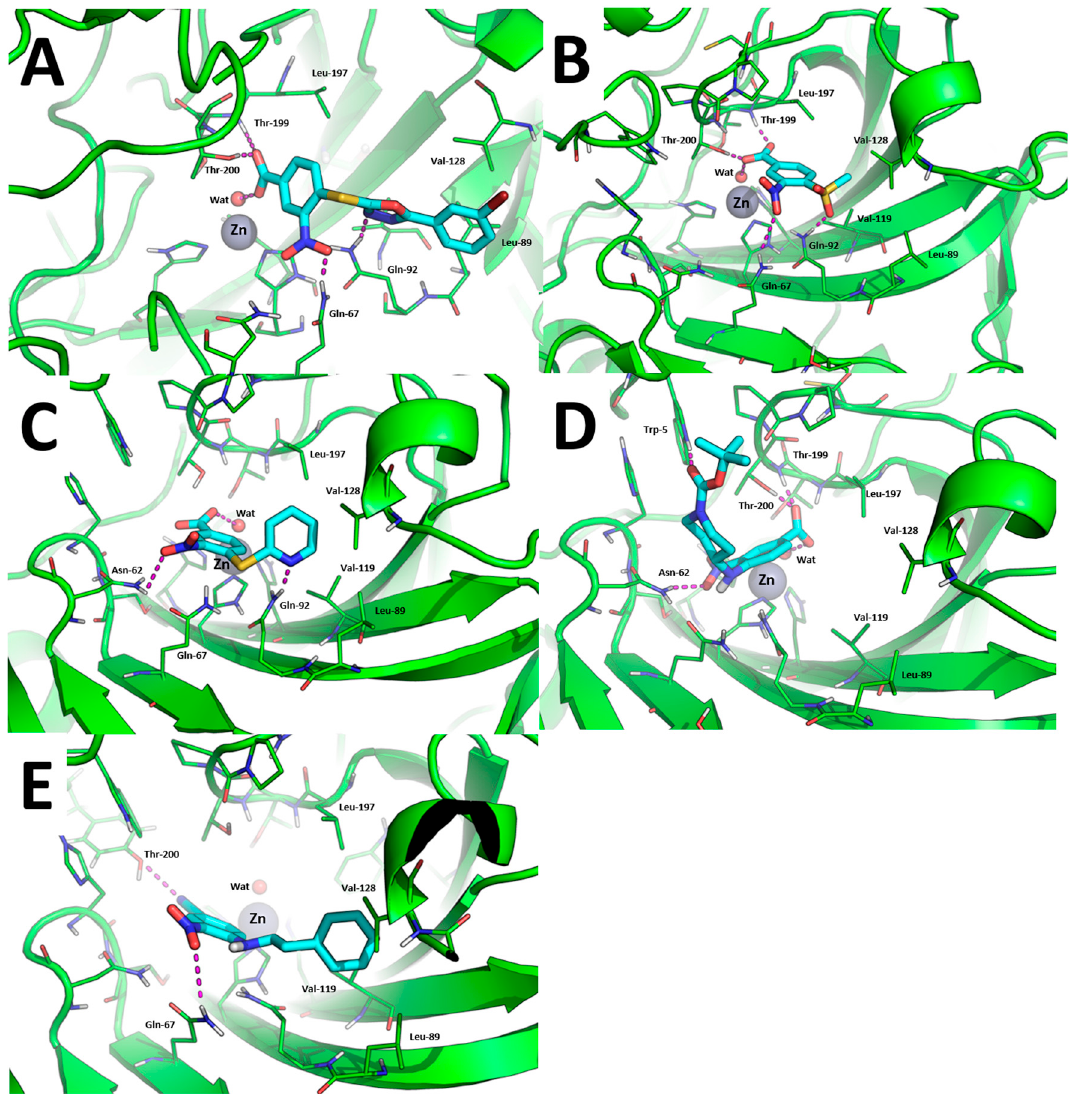
Figure 3. Binding mode of most promising hCA IX inhibitors predicted by molecular docking and energy minimization. ( A ) Compound 1 ; ( B ) compound 7 ; ( C ) compound 10 ; ( D ) compound 15 ; and ( E ) compound 19 . Small molecules are showed as cyan sticks, the 3D structure of hCA IX is showed as green cartoon. hCA IX residues involved in binding to compounds are showed as green lines and are labeled. H-bonds are highlighted as magenta dashed lines.